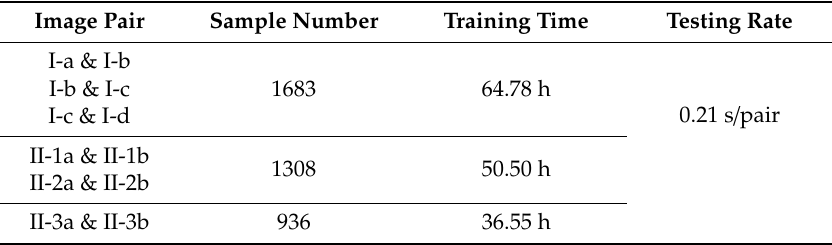
Table 2. Experimental information of our